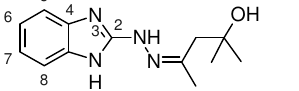
Figure 1 . Structure of the ligand